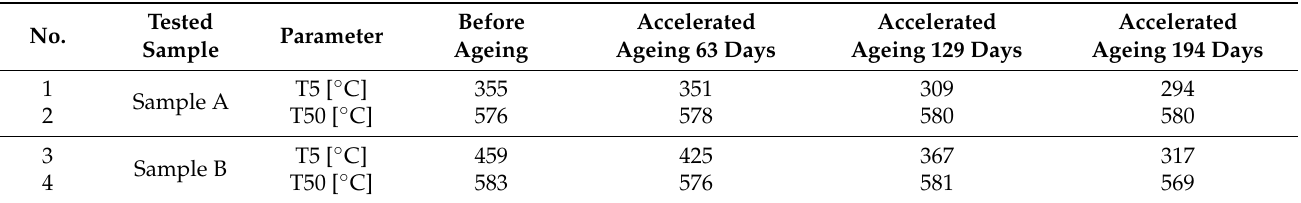
Table 1. The 5% and 50% temperature-induced mass loss of sample A and sample B